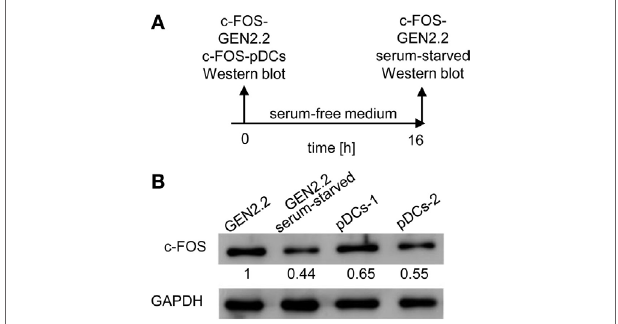
FigUre 7 | c-FOS in proliferating GEN2.2 cells, GEN2.2 cells starved in the serum-free medium and in primary plasmacytoid dendritic cells (pDCs). (a) Experimental outline. Total cell extracts were prepared from GEN2.2 cells immediately after their separation from MS-5 feeder cells (GEN2.2), GEN2.2 cells separated from MS-5 feeder cells and starved overnight in the serum-free medium (GEN2.2 serum-starved), and from primary pDCs isolated from two healthy donors by magnetic-bead purification without any further culture (pDCs-1, pDCs-2). (B) c-FOS levels were determined in the total cell extract by Western blotting by rabbit polyclonal Ab c-FOS (sc-52). The values shown below each band represent relative quantity of c-FOS determined by densitometry normalized to proliferating GEN2.2 cells. GAPDH was used as a loading